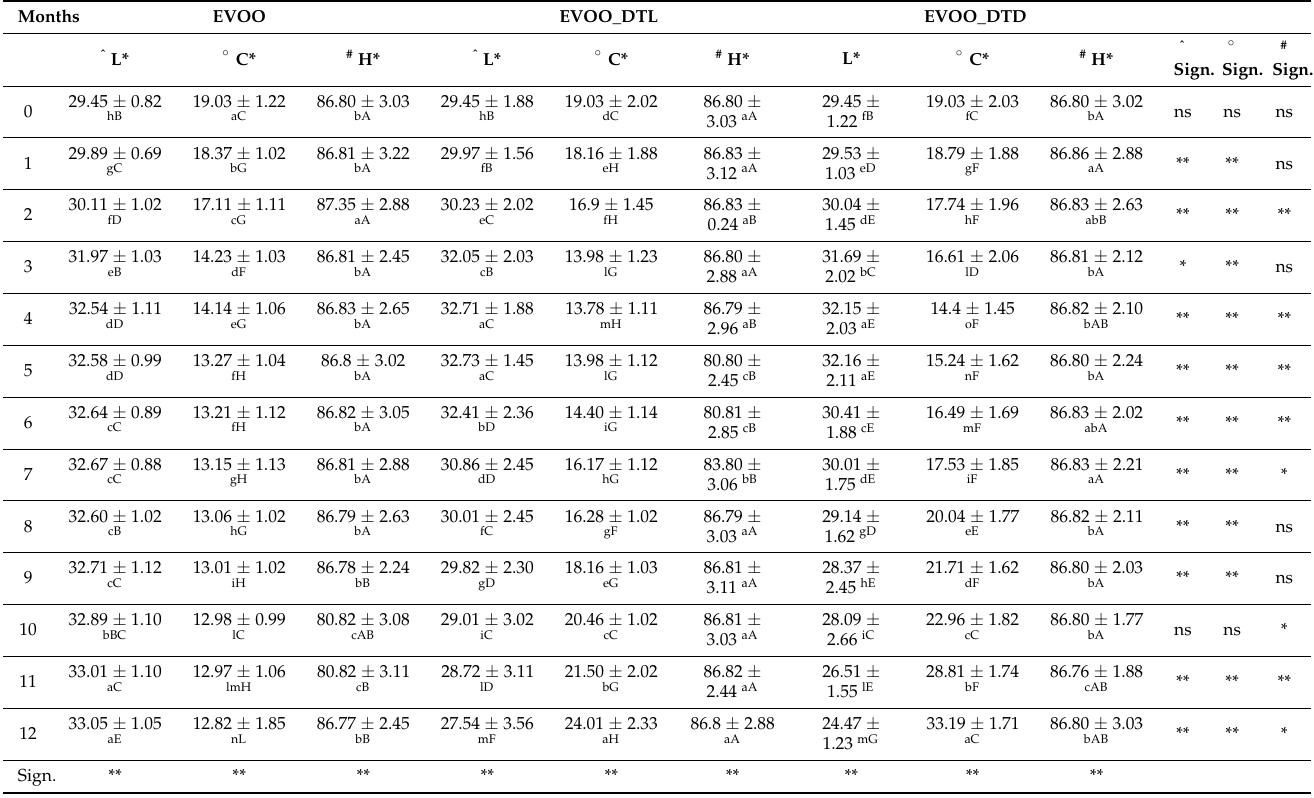
Table 5. CIELab color parameters (L*, C*, and H*) in EVOO, EVOO_DTD, and EVOO_DTL.